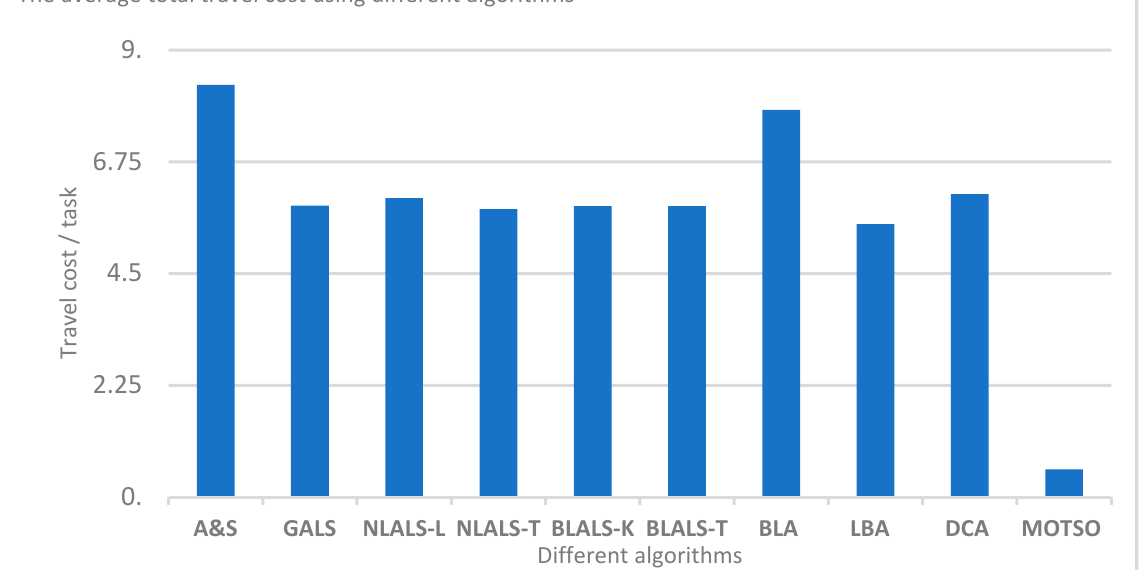
Table 12. The results of the standard deviation of the workload balance (WLB) using the MOTSO model.